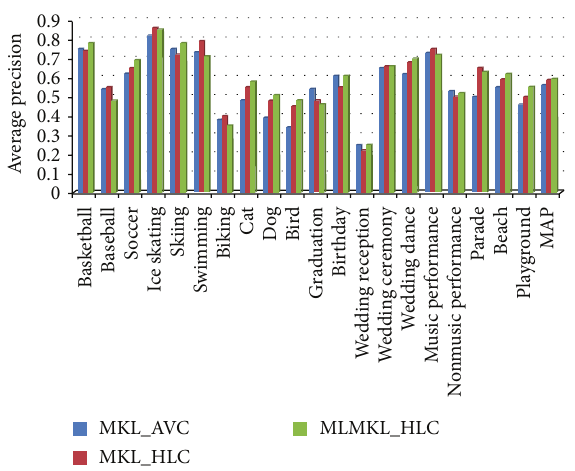
Figure 4: Performance of high-level features on CCV dataset.